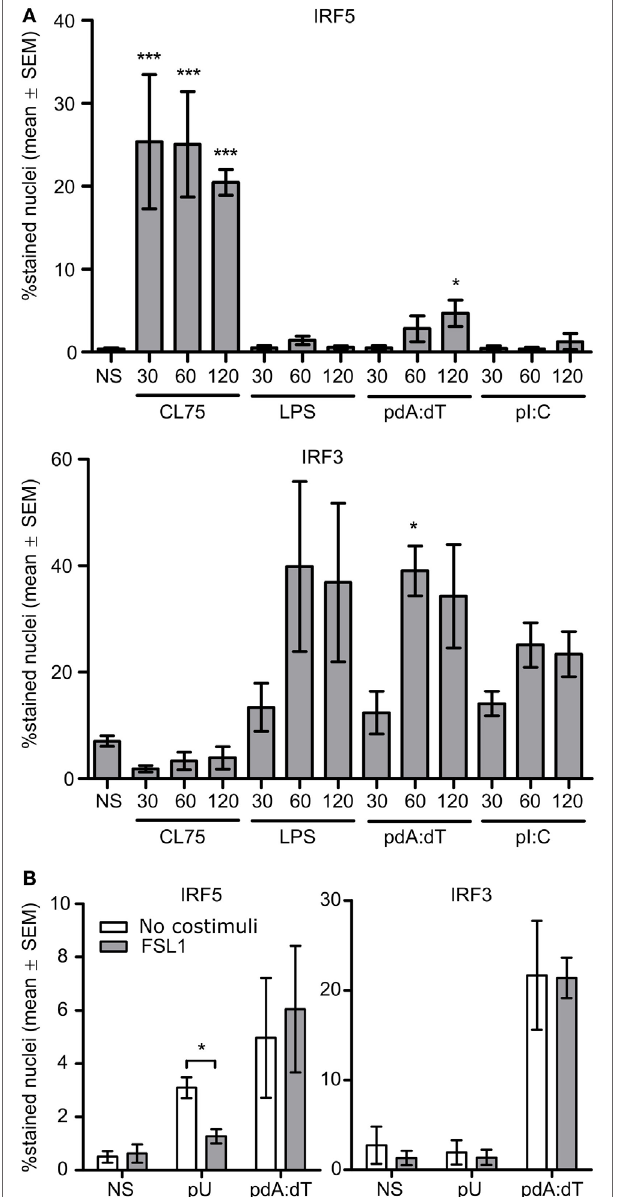
FigUre 4 | IFN regulatory factor 5 (IRF5) is activated by TLR8 ligands and cytosolic dsDNA sensing, IRF3 is activated by TLR4 signaling and cytosolic dsDNA and dsRNA sensors, while only TLR8 is antagonized by TLR2 ligand. (a) Monocytes were stimulated with CL75 (1 μ g/ml), LPS (K12, 100 ng/ml), pdA:dT (dsDNA, 1 μ g/ml), or poly(I:C) (dsRNA, 1 μ g/ml). The nucleic acid ligands were transfected using L2K. Fixation was done at 30, 60, and 120 min poststimulation and IF staining of IRF5 and IRF3 was performed. (B) Monocytes were stimulated with the TLR8 agonist polyuridylic acid (pU) in complex with poly- l -arginine (pLA) or with pdA:dT/L2K. The ligands (1 μ g/ml) were added alone or together with FLS-1 (100 ng/ml), and cells were fixed and stained after 120 min of incubation. Quantification of nuclear accumulation was done by high-content screening (Scan^R, 20 × ). Significance was tested relative to no stimuli (NS). n =